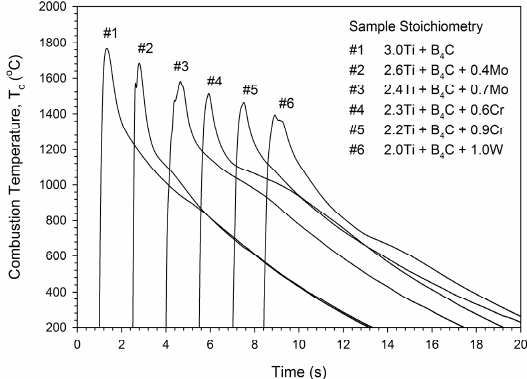
Figure 3. Combustion temperature profiles of Ti ‐ B 4 C samples added with different amounts of Cr, Mo, or W.